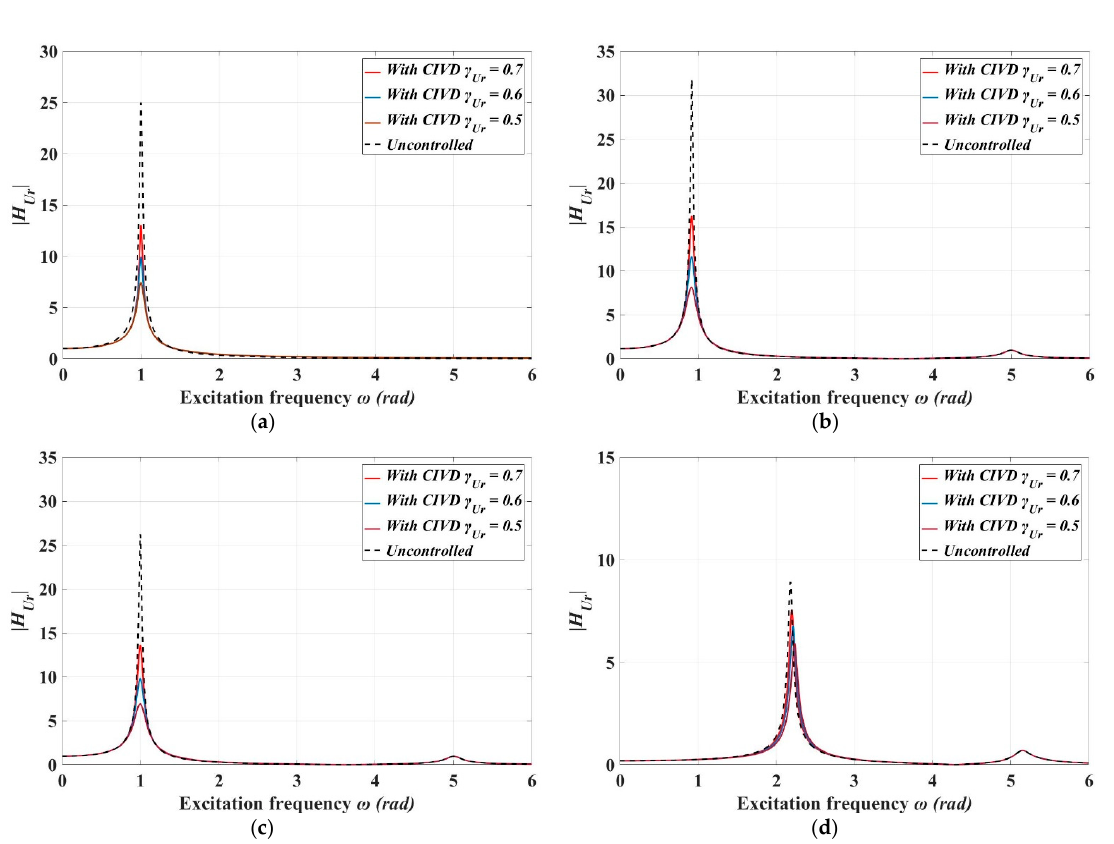
Figure 15. Transfer function curves of relative displacement of grotto-eaves system: ( a ) β = 0; ( b ) β = 0.2; ( c ) β = 1; and ( d ) β = 5. Figures 16 and 17 show the displacement amplification factor of eaves and transfer function of deformation of damping element of CIVD in SC system with different optimal design methods. It can be seen from Figures 16 and 17 that the maximum displacement of demand-based optimal method is less than it of the fixed-point method. Meanwhile, the damping element deformation enhancement of the inerter system can be brought into full play by using demand-based optimal method. Hence, the demand-based optimal method can minimize the cost by enhancing damping element deformation in a small damping ratio. ( a ) ( c ) Figure 16. Displacement amplification factor of eaves in SC system: ( a ) γ Ur = 0.7; ( b ) γ Ur = 0.6; and ( c ) γ Ur = 0.5. ( a )